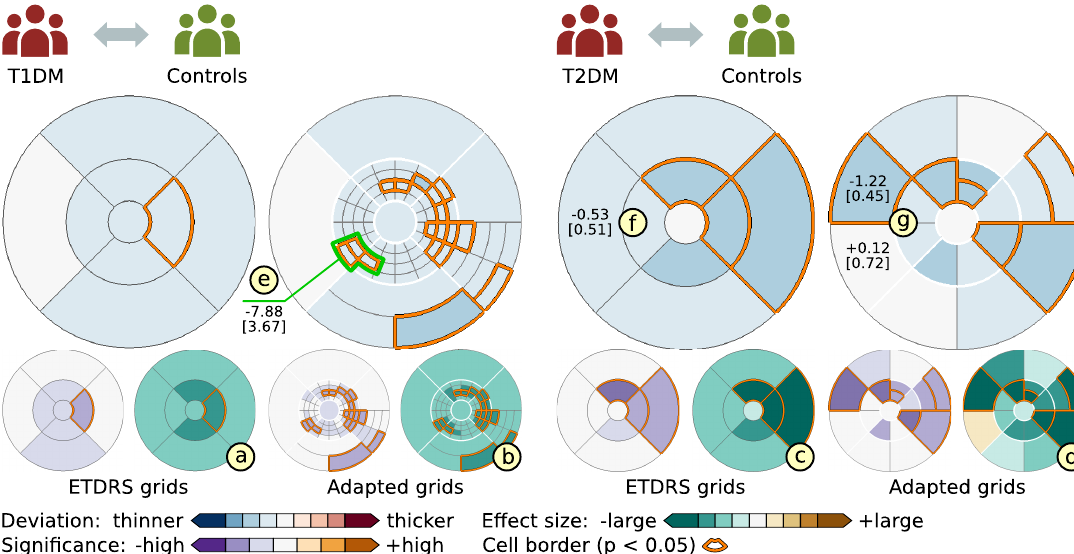
Figure 11. Exemplary results of two cross-sectional studies. The grids represent TR in pediatric T1DM patients ( a,b ) and RNFL in a subgroup of adult T2DM patients ( c,d ) compared to matched controls. Cell color encodes thickness deviation, statistical significance, or effect size. Highlighted cell borders mark significant differences ( p < 0.05). In T1DM patients, the ETDRS grids ( a ) depict significant thinning limited to a single cell. The subdivided grids ( b ) show additional cells of significant localized thinning and measurements of multiple small cells ( e ). In T2DM patients, the ETDRS grids ( c ) present a general overview of thickness deviation. The subdivided grids ( d ) show more details of the spatial distribution and degree of thinning. Some ETDRS grid cells underestimate the thinning ( f ) compared to corresponding subdivided grid cells ( g